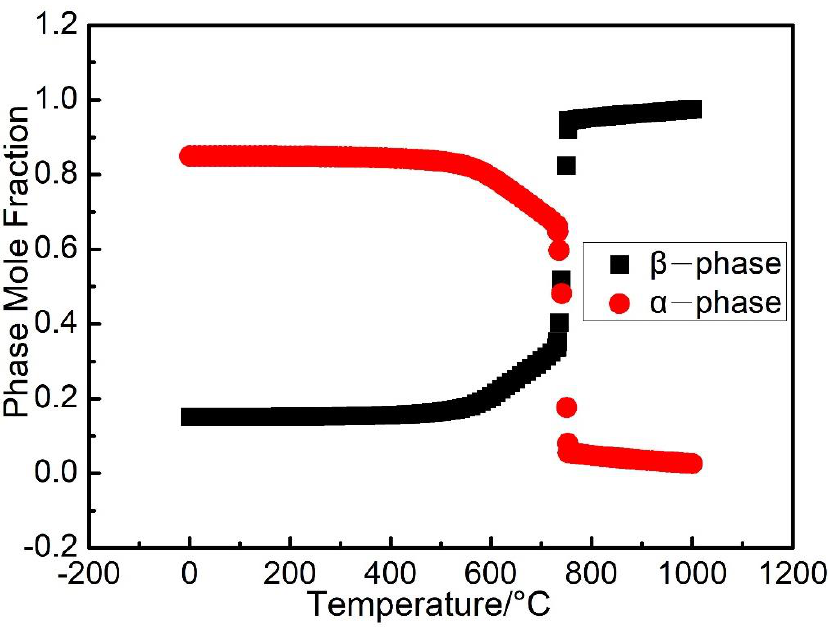
Figure 14. The calculated equilibrium phase diagram of Ti-24Nb-4Zr-7.85Sn-0.22O (wt.%) alloy.